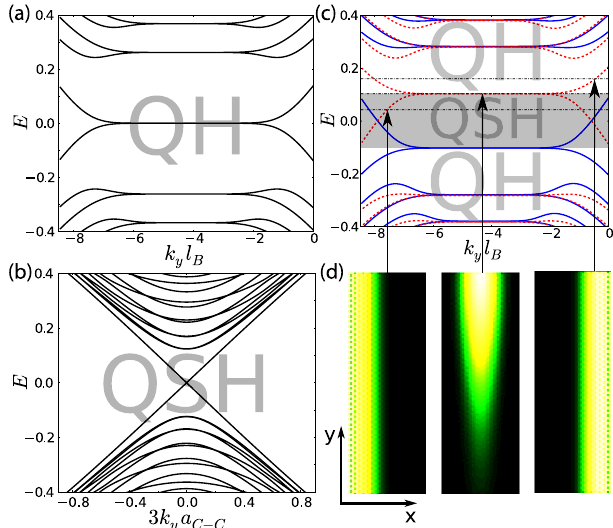
FIG. 2. Band structure of a (semimetallic armchair) graphene ribbon in the (a) QH and (b) QSH phase. When both magnetic- field coupling and SO coupling are present (c), the resulting band j < (cid:2) (shaded region) structure leads to a QSH phase for j E F so j > (cid:2) . Compared to the pure QH and and a QH phase for j E F so QSH cases, the spin degeneracy is lifted (blue thick lines and red dotted lines), seen as particularly prominent in the lowest band . As the which consists of spin-polarized branches at E ¼ (cid:3) (cid:2) so Fermi energy crosses the SO gap, the localization of the unhappy spin (red dotted lines) shifts from one edge to the other, while it ¼ (cid:2) . This is illustrated is fully localized in the bulk when E F so in the corresponding current-density plots (d). On the other hand, the happy spin (thick blue) gets increasingly localized on the same edge as the Fermi energy crosses the transition region (not ¼ 0 : 02 , l B ’ 8 , and a shown). The parameters used are (cid:1) ffiffiffi p so ribbon width W ¼ 40 3